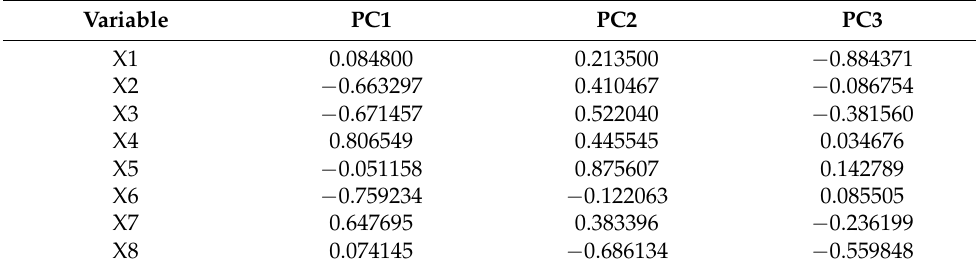
Table 1. Values of the weights of variables within the main components.